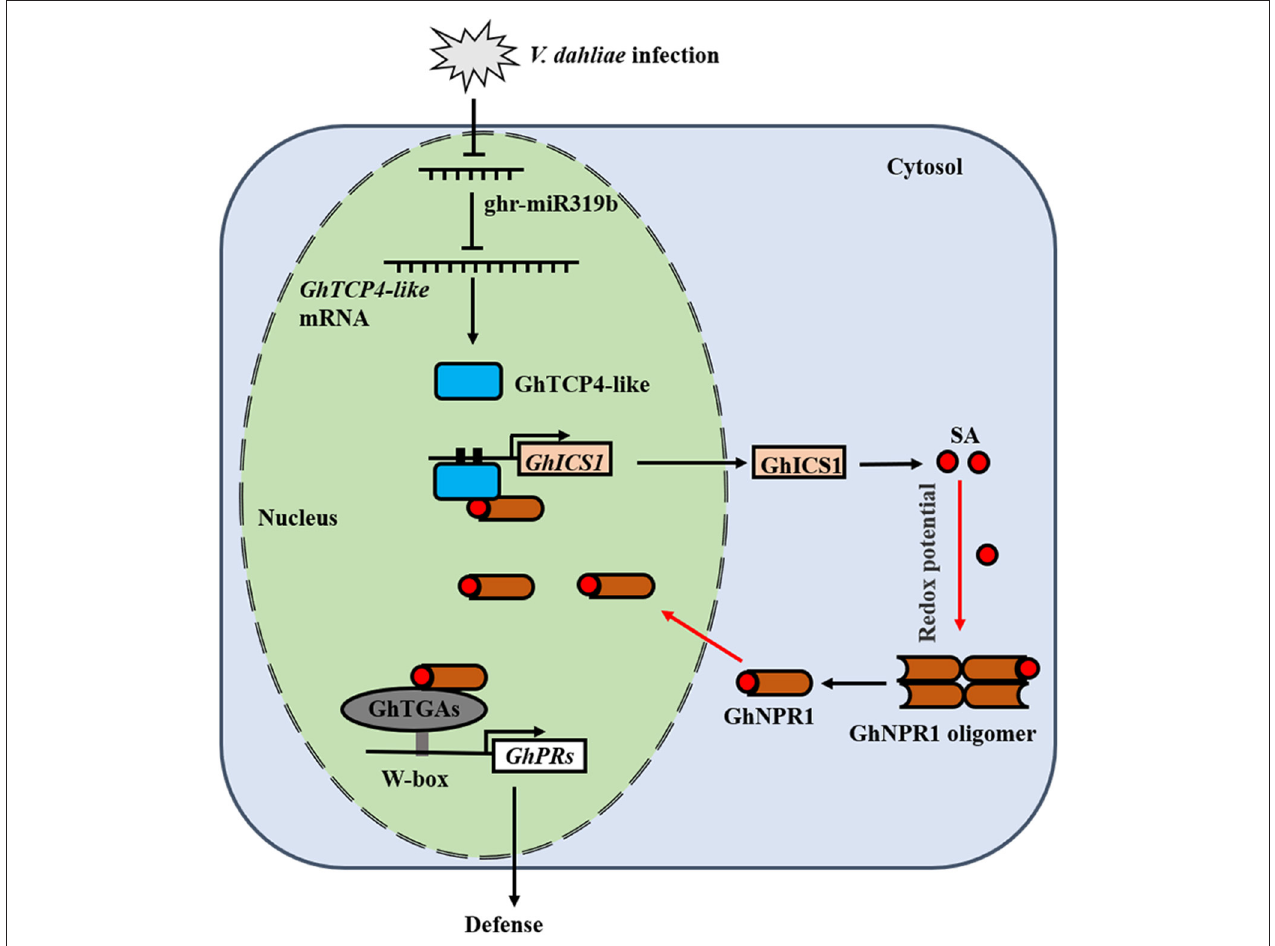
FIGURE 8 | Working model diagram of ghr-miR319b-GhTCP4-like module in defense against V. dahliae infection. V. dahliae invasion releases the effectors or PAMPs to inhibit ghr-miR319, increasing GhTCP4-like expression, which transactivates GhICS1 expression to promote SA biosynthesis. GhNPR1 interacting with GhTCP4-like enhances activation activity of GhTCP4-like to GhICS1 transcription in feedback regulation loop of SA biosynthesis, facilitating in plant high resistance to V. dahliae infection. NPR1 interacting with TGAs promotes defense-related gene expression to increase plant resistance to pathogens. The black arrows represent regulation positively, the T-shaped arrows represent regulation negatively, the red arrows represent